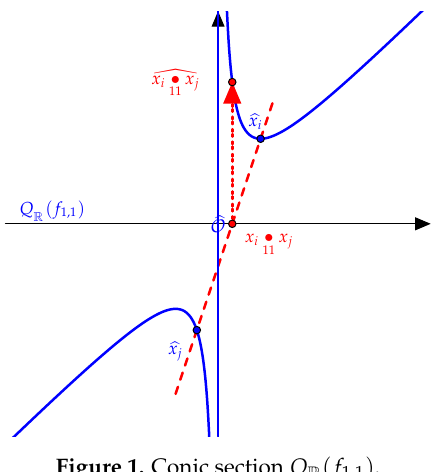
Figure 1. Conic section Q R ( f 1,1 ) .